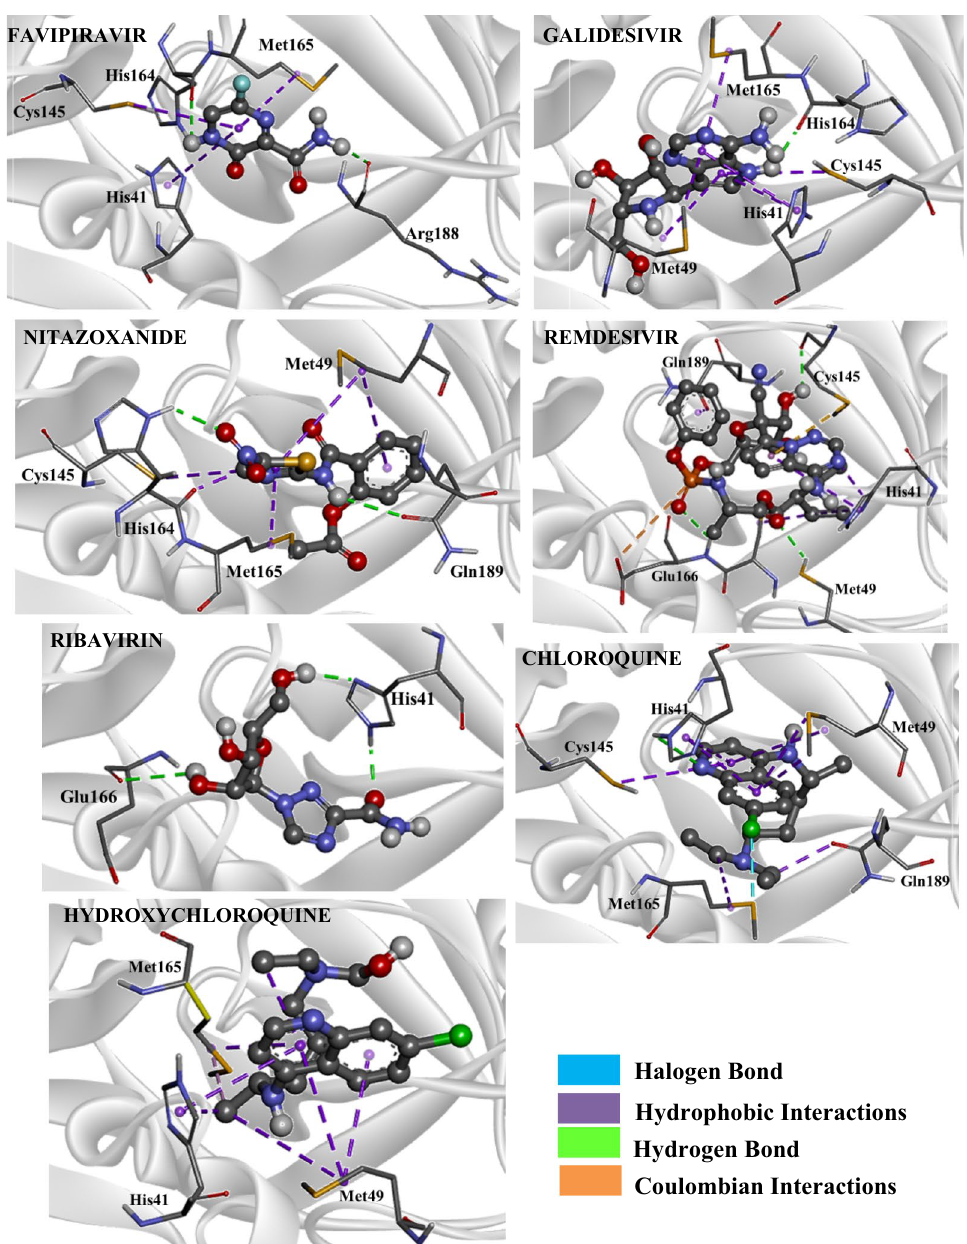
Figure 4. Intermolecular interactions of the drugs investigated in the M pro binding site. Image generated in the Visual Molecular Dynamics 1.9.3 https:// www. ks. uiuc. edu/ Resea rch/